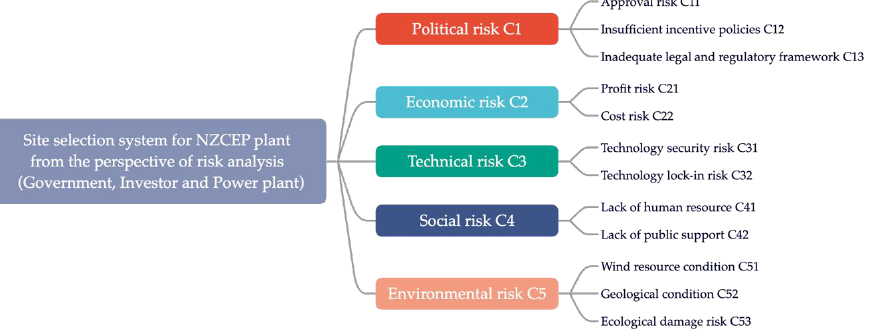
Figure 2. The risk factor system for NZCEP plant.